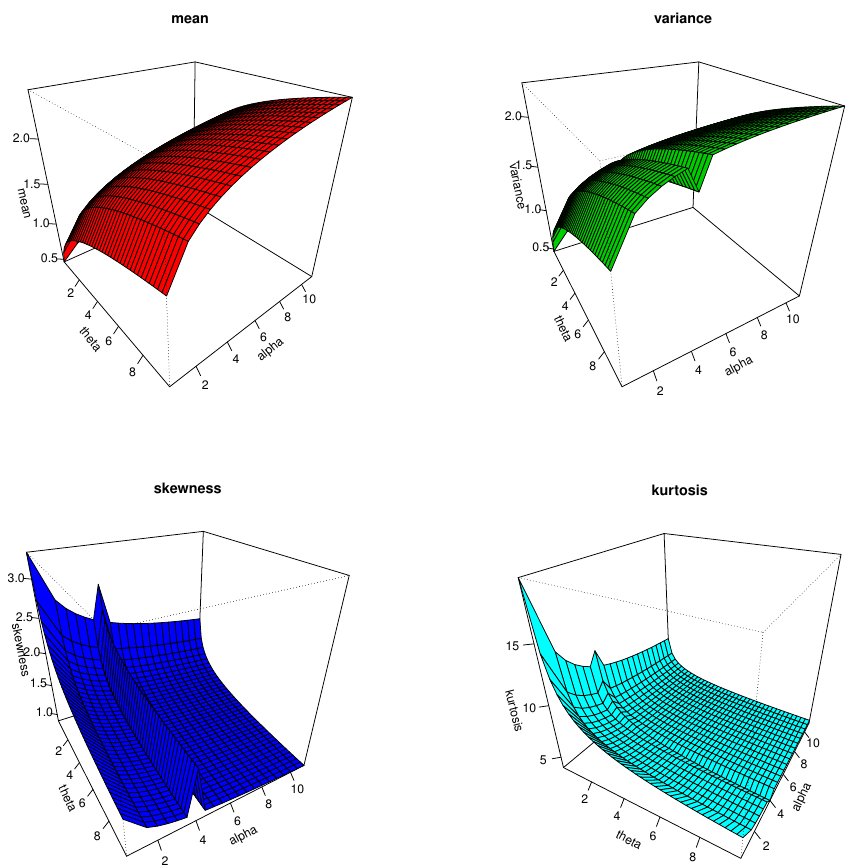
Figure 3. Mean, variance, skewness and kurtosis of LTAPEx